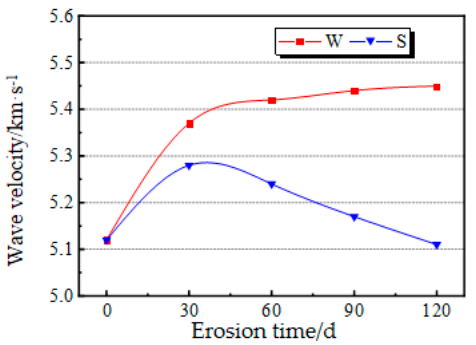
Figure 8. Changes in wave velocity with erosion time.